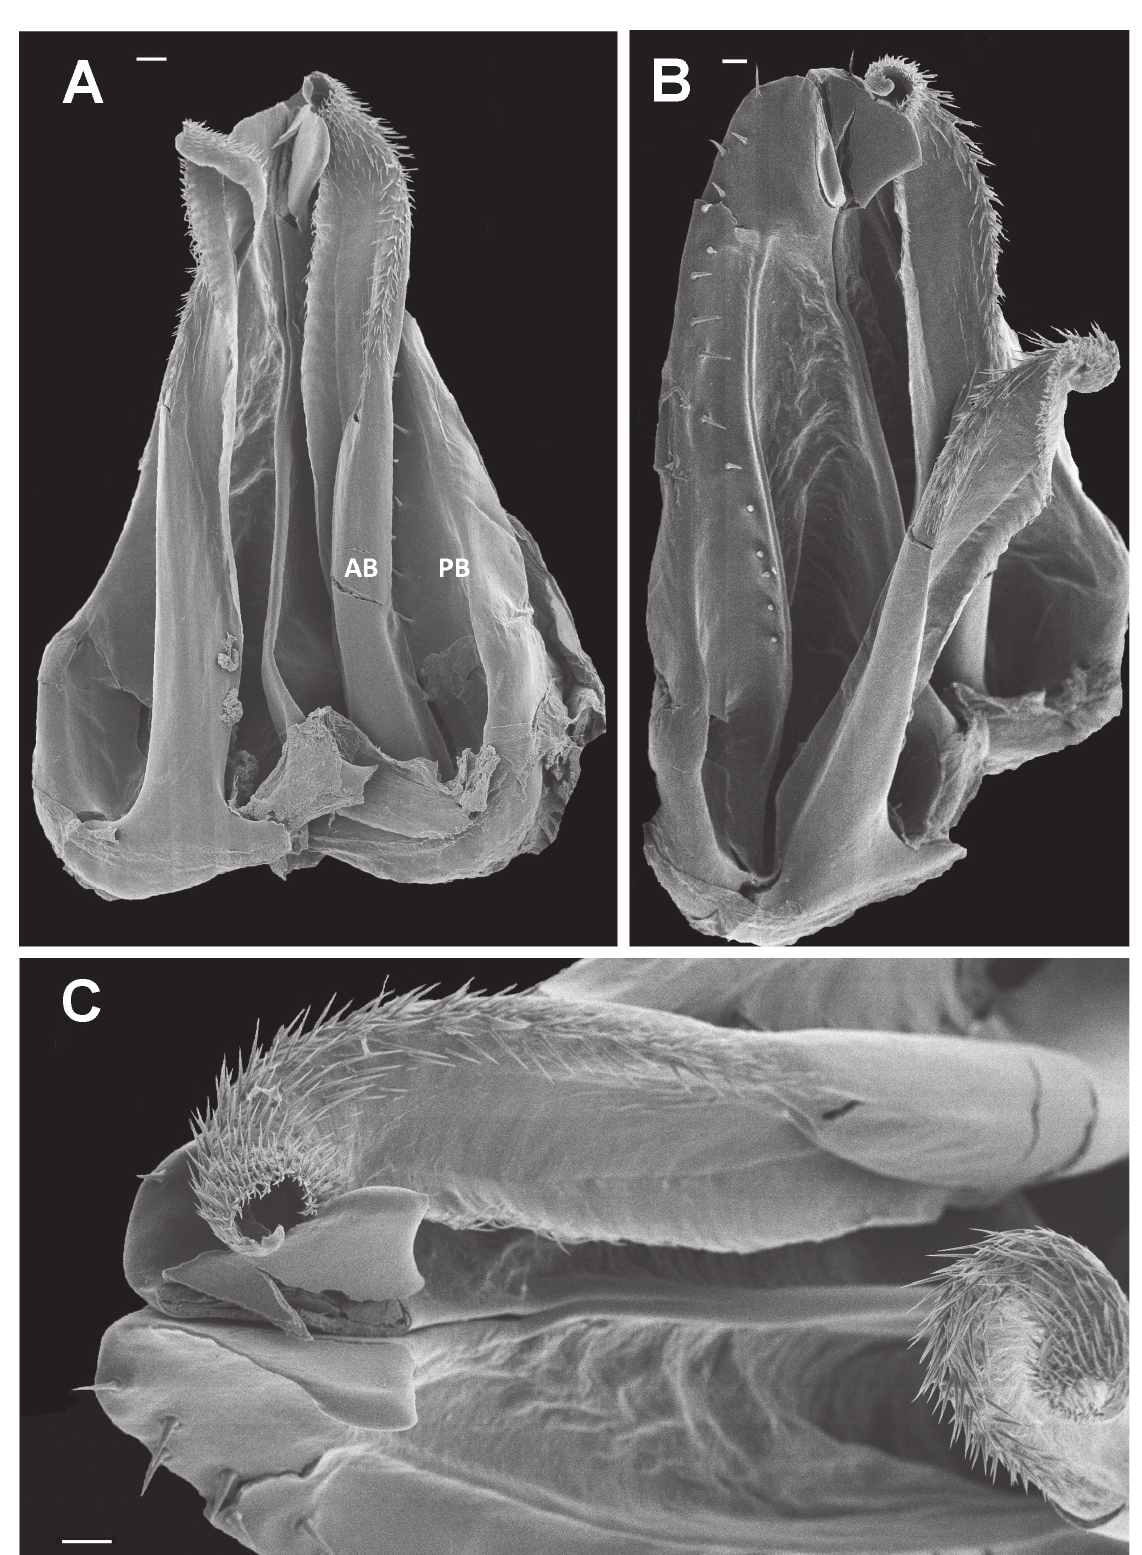
Fig. 8. Koiulus interruptus gen. et sp. nov., paratype, ♂, from the upper course of the river Ko, posterior gonopods. A . Anterior view. B . Posterior-lateral view. C . Posterior-apical view. Abbreviations: AB = anterior branch; PB = posterior branch. Scale bars = 0.02